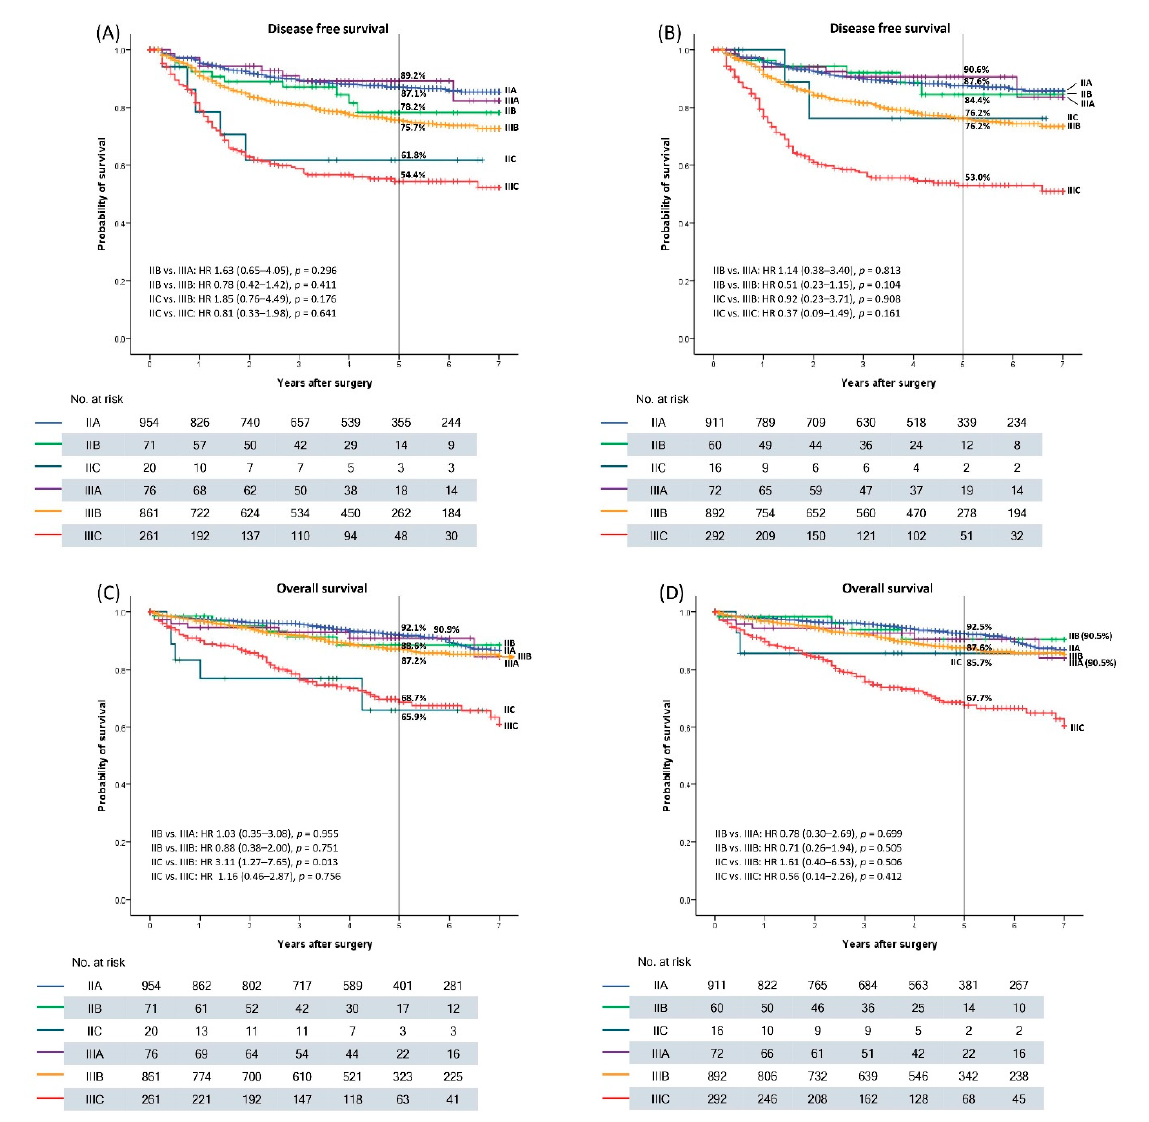
Figure 2. Kaplan–Meier curve in stage II–III colon cancer. ( A ) Disease-free survival (DFS) in TN stage. ( B ) DFS in new TNV stage. ( C ) Overall survival (OS) in TN stage. ( D ) OS in new TNV stage.